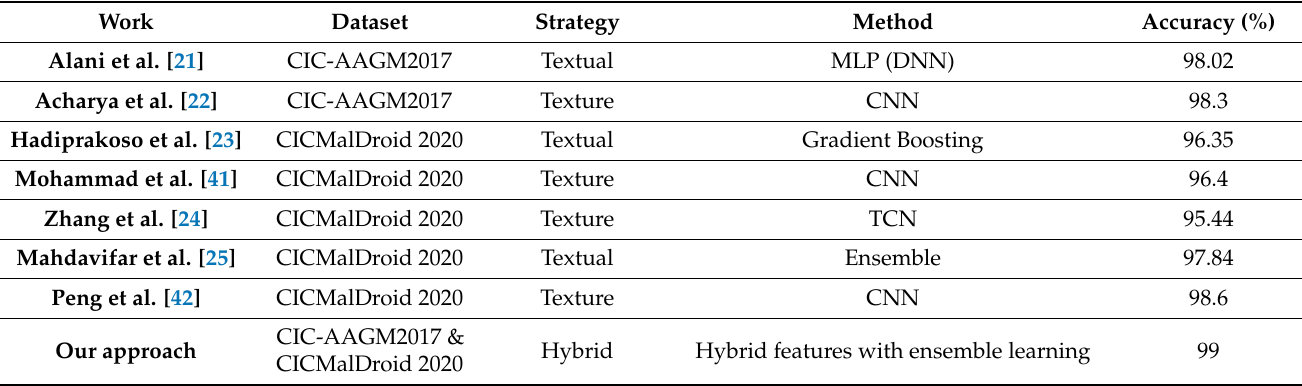
Table 11. Performance comparison with state-of-the-art methods using the same